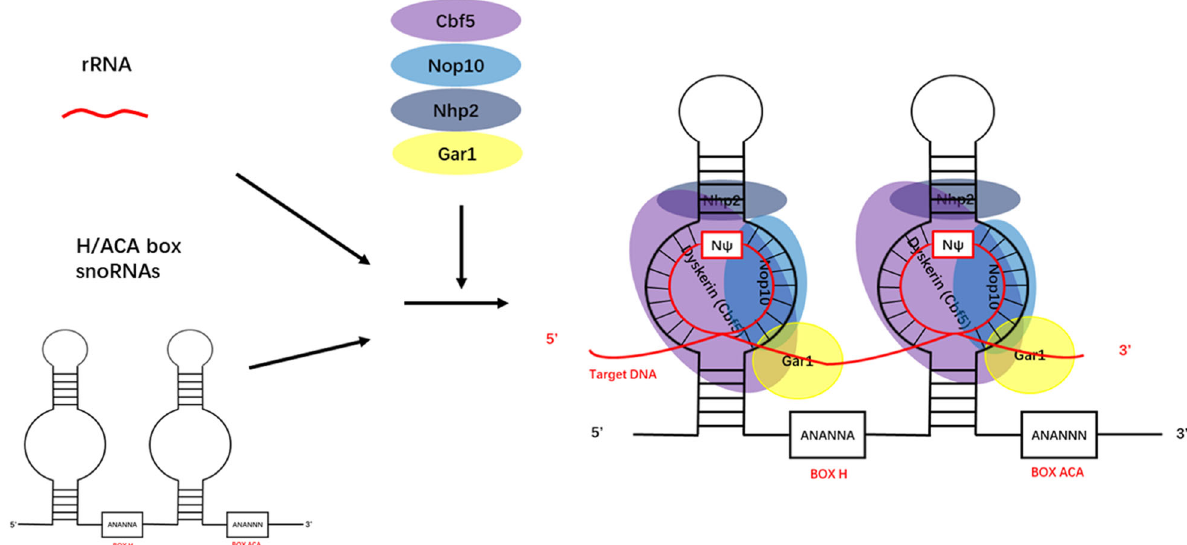
Fig. 5 H/ACA box snoRNPs modi fi e the target RNA by Pseudouridylation. The H/ACA box snoRNAs form functional snoRNPs through binding to core proteins, including Cbf5p, Nop10p, Nhp2p and Gar1p. SnoRNPs bind to target RNA by their pseudouridylation pockets. In these pseudouridylation pockets, the target uridine in the target RNA is modi fi ed into pseudouridine.